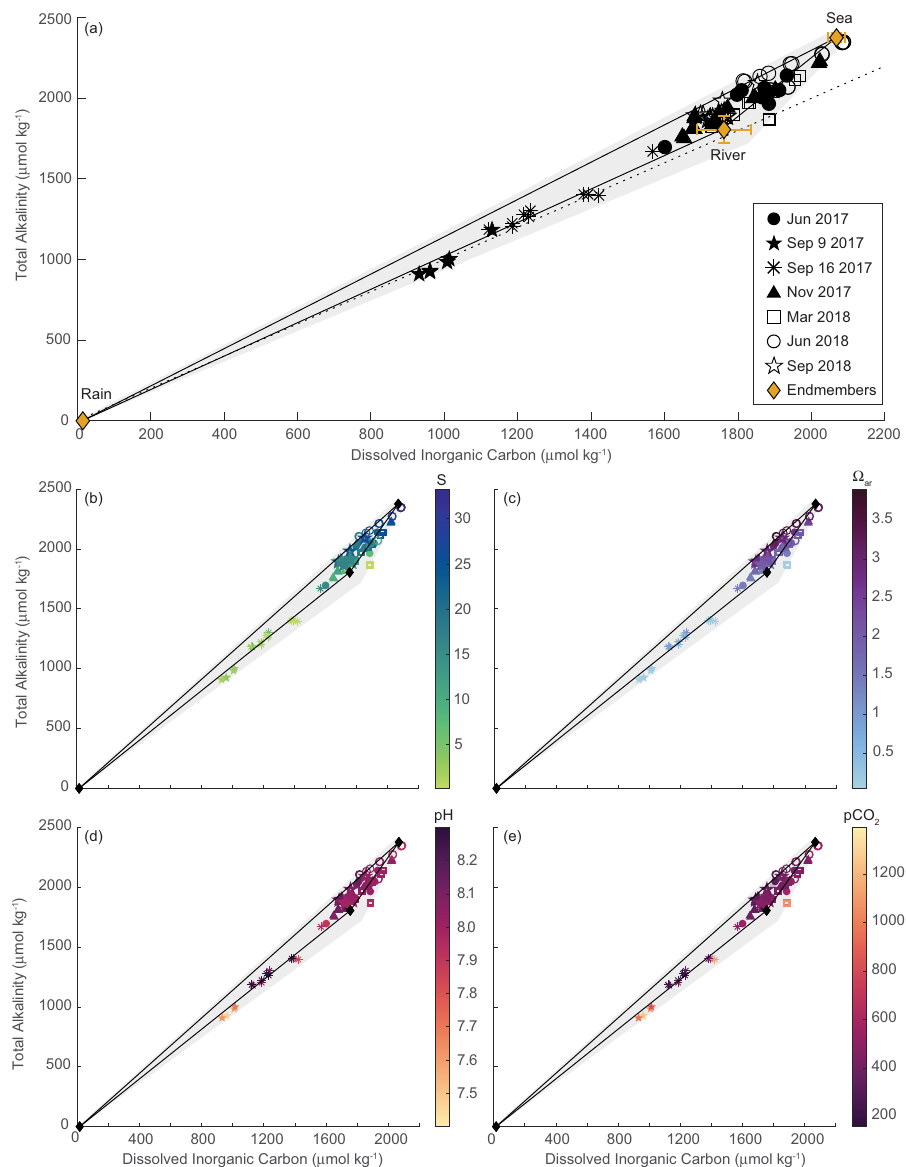
Fig. 3 Total alkalinity (TA) as a function of dissolved inorganic carbon (DIC) in Galveston Bay from June 2017 to September 2018. For all plots, symbols are categorized according to sampling month (shape) and year ( fi ll). Shapes: squares for March, circles for June, stars or asterisk for September, triangles for November; fi lled symbols for 2017 and open symbols for 2018. Diamonds indicate the average calculated endmember values connected by dark gray mixing lines. The standard deviation for each average endmember (error bars on endmembers in ( a )) was used to determine the uncertainty associated with the mixing envelope shown by the gray shaded region. The mixing envelope uncertainty includes seasonal variability in the endmember values. The dotted line in ( a ) indicates a comparative 1:1 relationship for TA:DIC and endmembers are highlighted in yellow for clarity in ( a ). Color bars show values for b salinity (S), c aragonite saturation state ( Ω ar ), d pH, and e partial pressure of carbon dioxide (pCO 2